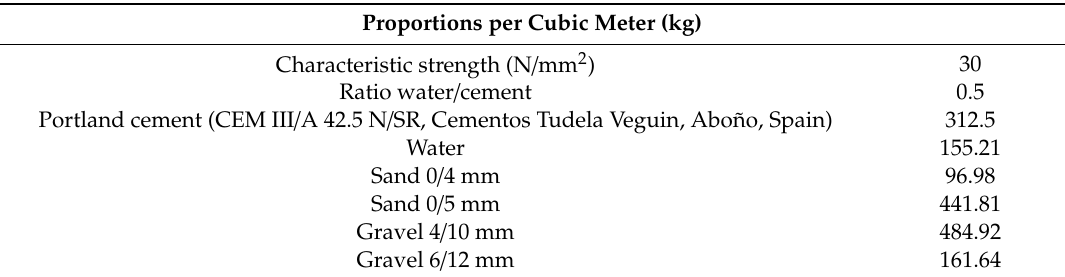
Table 1. Concrete mix design.